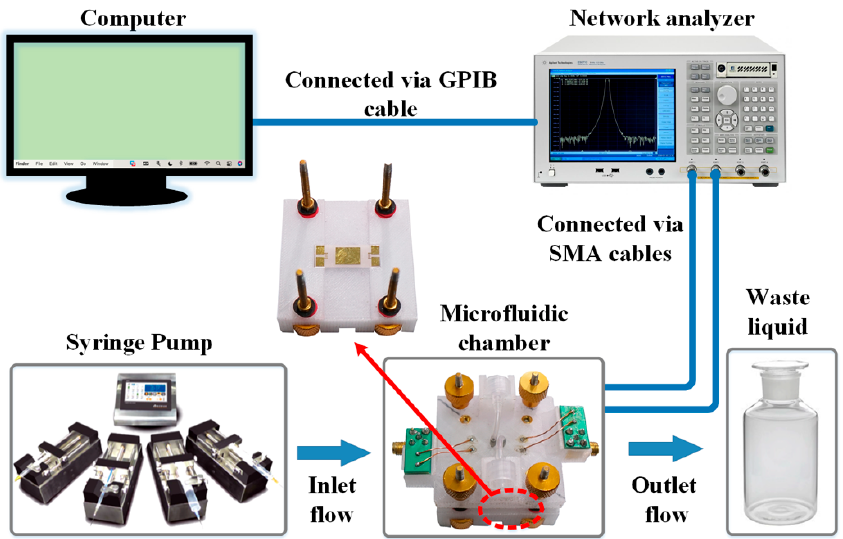
Figure 2. Experimental setup of SAW immunosensor, including a syringe pump, microfluidic chamber, network analyzer, and PC.